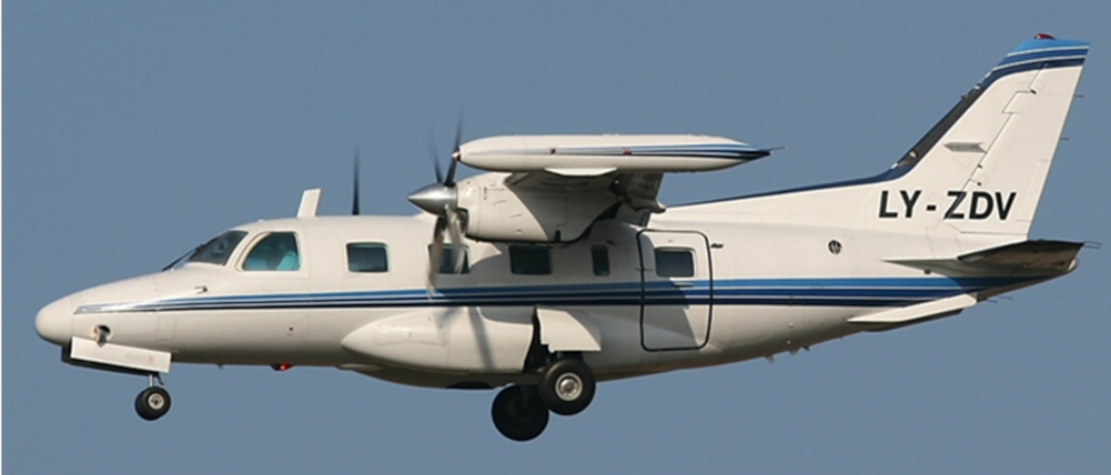
Figure 8. Mitsubishi MU-2B (Photograph by Alan Lebeda [25], trimmed, GFDL